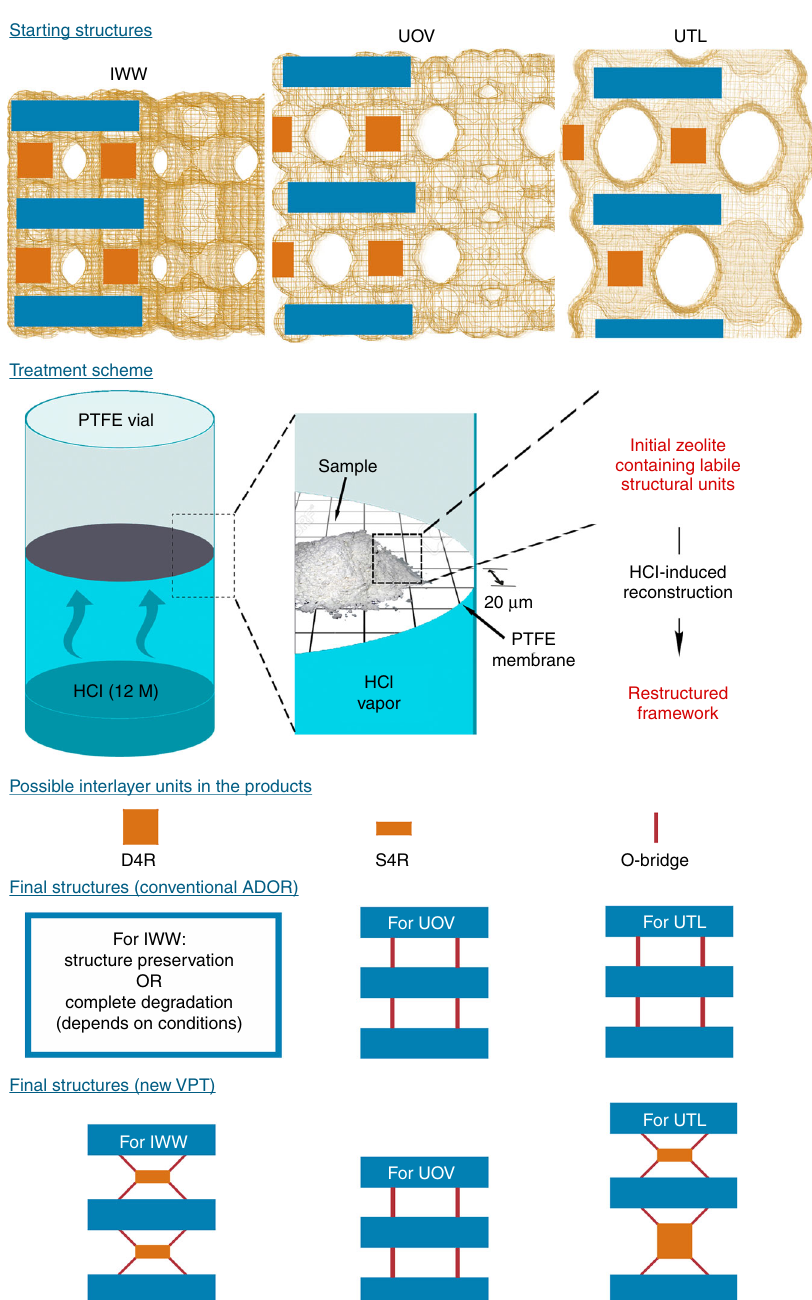
Fig. 1 Starting materials for VPT and respective products. Structures of initial zeolites are porous frameworks composed of layers (blue tetragons) and connecting D4R units (orange squares). Vapour of HCl (blue on treatment scheme of the VPT method) interacts with solid zeolite resulting in structural transformation accompanied by leaching of Ge atoms probably as GeCl 4 . Respective D4R units can be either reconstructed to S4Rs or decomposed. Final structures obtained via conventional ADOR and VPT rearrangement of the parent zeolites ( IWW , UOV and UTL ) are different due to the difference in layers porosity, thus in the interlayer species diffusion